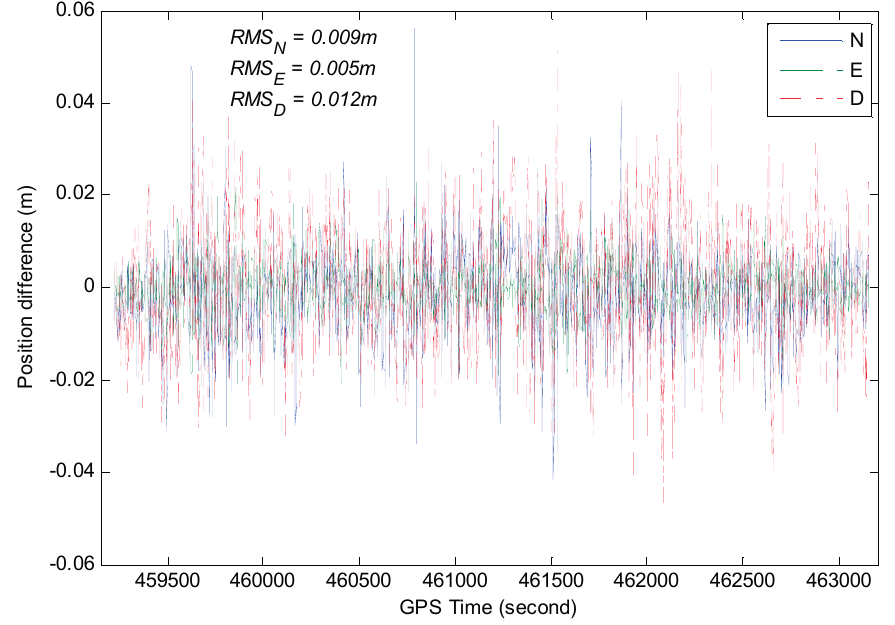
Figure 16. Position differences between GPS/BDS/INS integration solution and GPS/BDS solution (20° cut-off